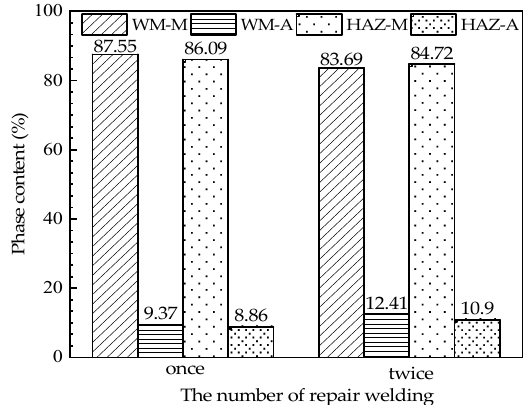
Figure 6. Contents of martensite and reversed austenite in once and twice repair welded joints.